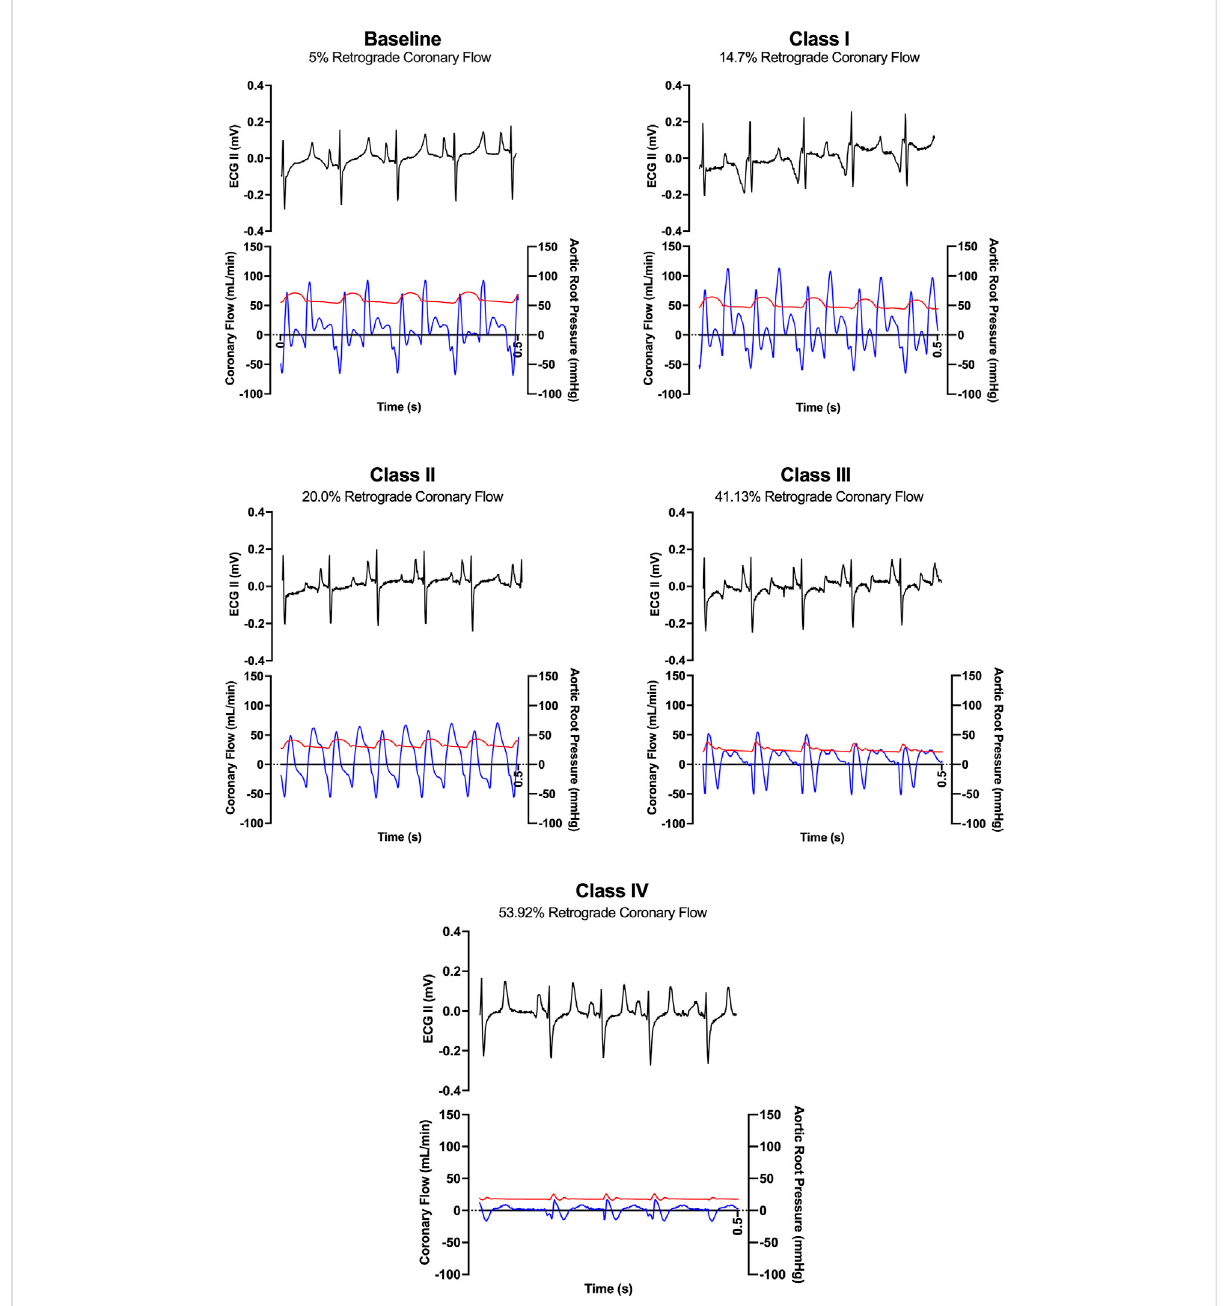
FIGURE 5 Representative ECG tracings (black) and coronary fl ow tracings (blue) superimposed on aortic pressures (red) over time (0.5 s) from one animal during baseline and each class of hemorrhagic shock (I-IV).